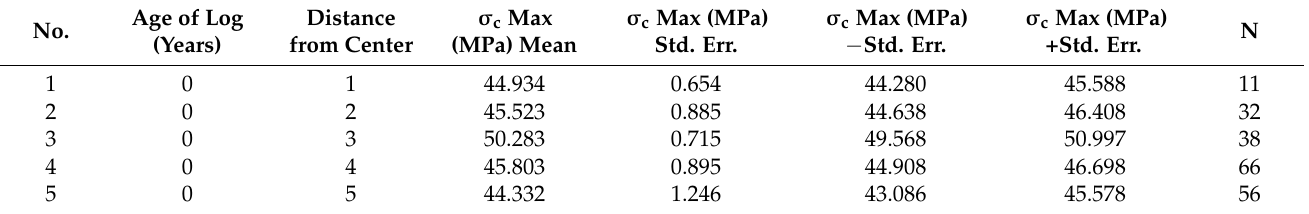
Table 8. ANOVA spreadsheet—Age of log and distance from center—influence on compressive